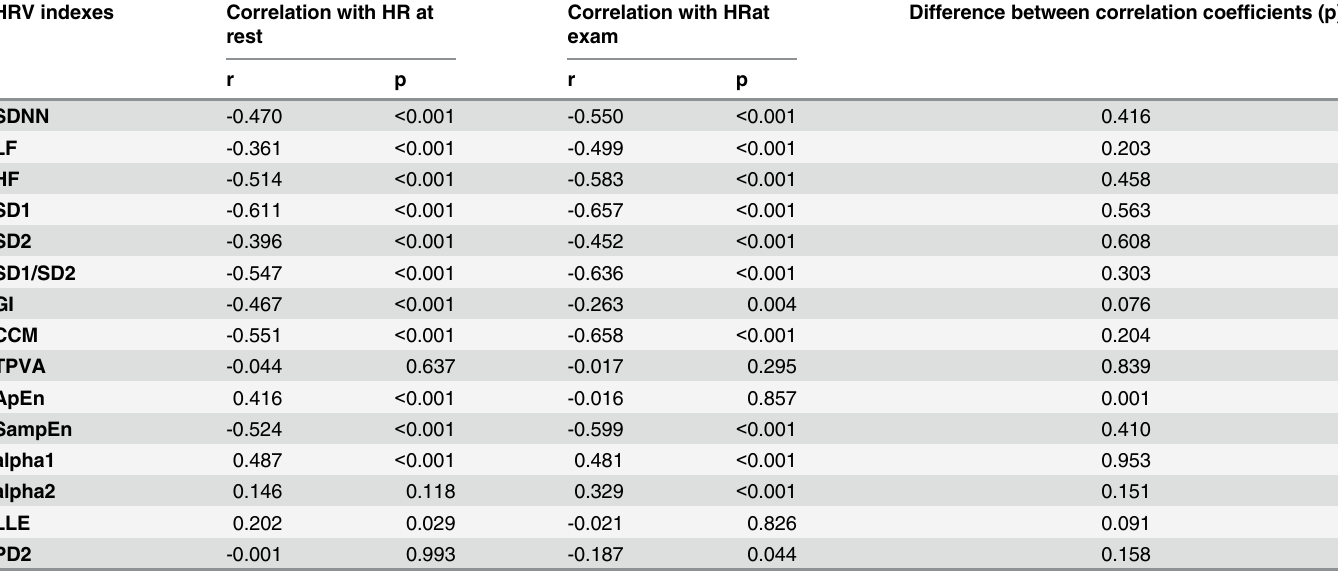
Table 2. Pearson correlations between Poincaré plot dimensions, measures of entropy, short- and long-term exponents, Largest Lyapunov expo- nent, pointwise correlation dimension, and heart rate. HRV indexes Correlation with HR at Correlation with HRat Difference between correlation coef fi cients rest exam